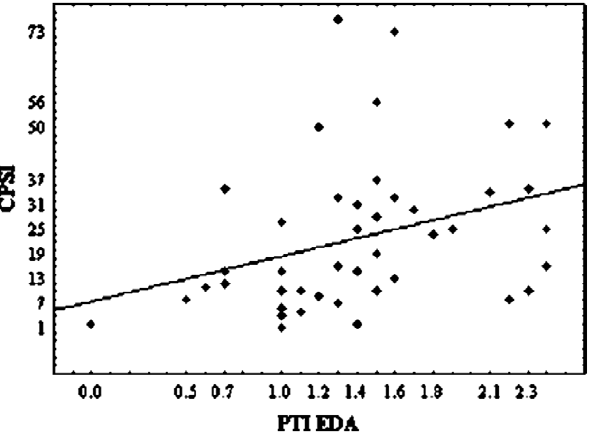
Figure 1. Dependency graph between pointwise transinforma- tion- PTI (in bits) and complex partial seizure-like symptoms- CPSI (r=0.43, p=0.004).